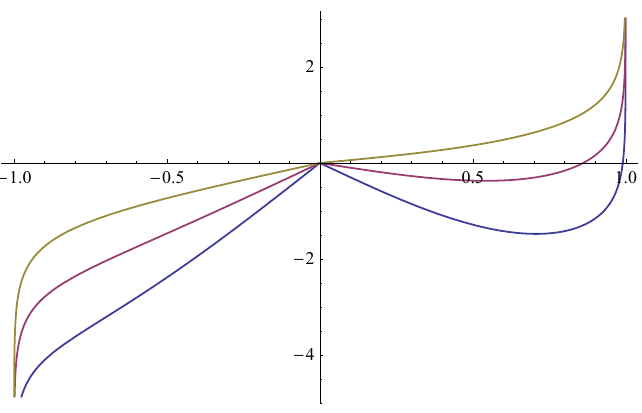
√ 2 α ( x − x ) as a function of φ/a for 0